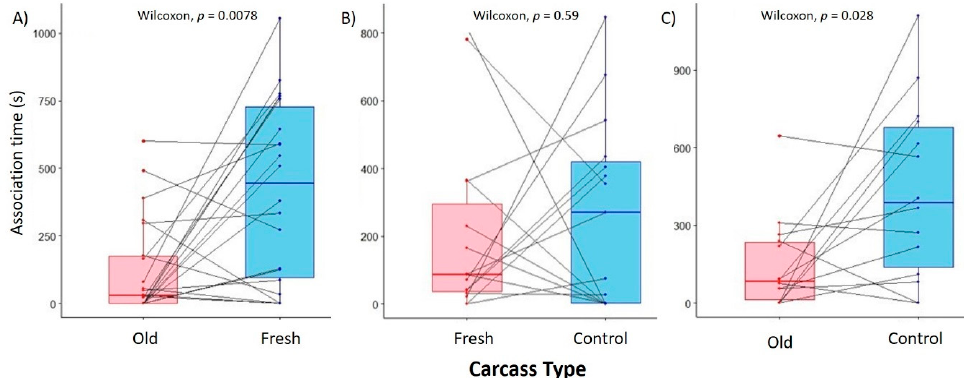
Figure 2. Box-and-whisker plots depicting mean female Nicrophorus vespilloides association times between choice chambers. ( A ) Old vs. Fresh carcass assay, ( B ) Fresh vs. Control assay, ( C ) Old vs. Control assay. Lines represent individual assays connecting the association times with both chambers for a given gravid female. Data points refer to association times of individual females, and boxplots denote median values and upper and lower quartiles.